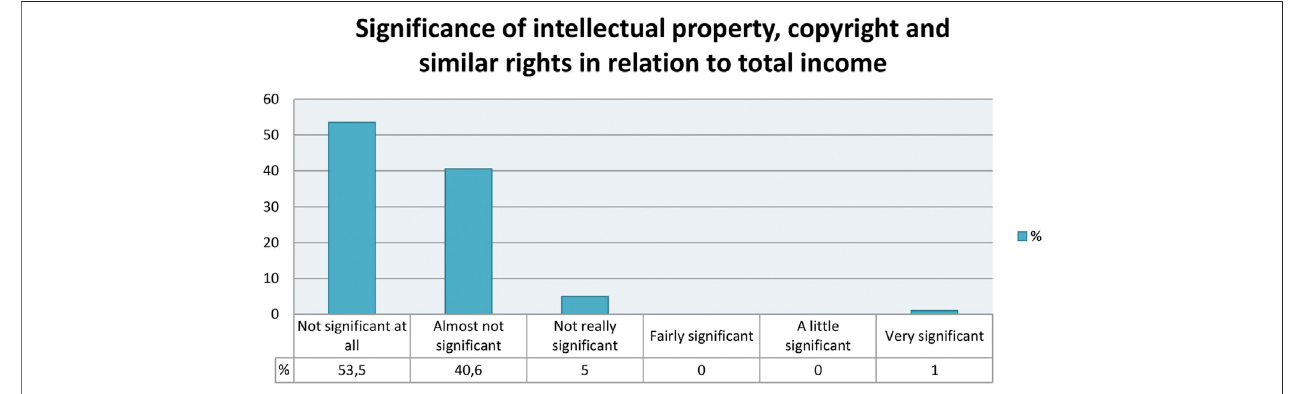
FIGURE 2 | Signi fi cance of intellectual property, copyright and similar rights in relation to total